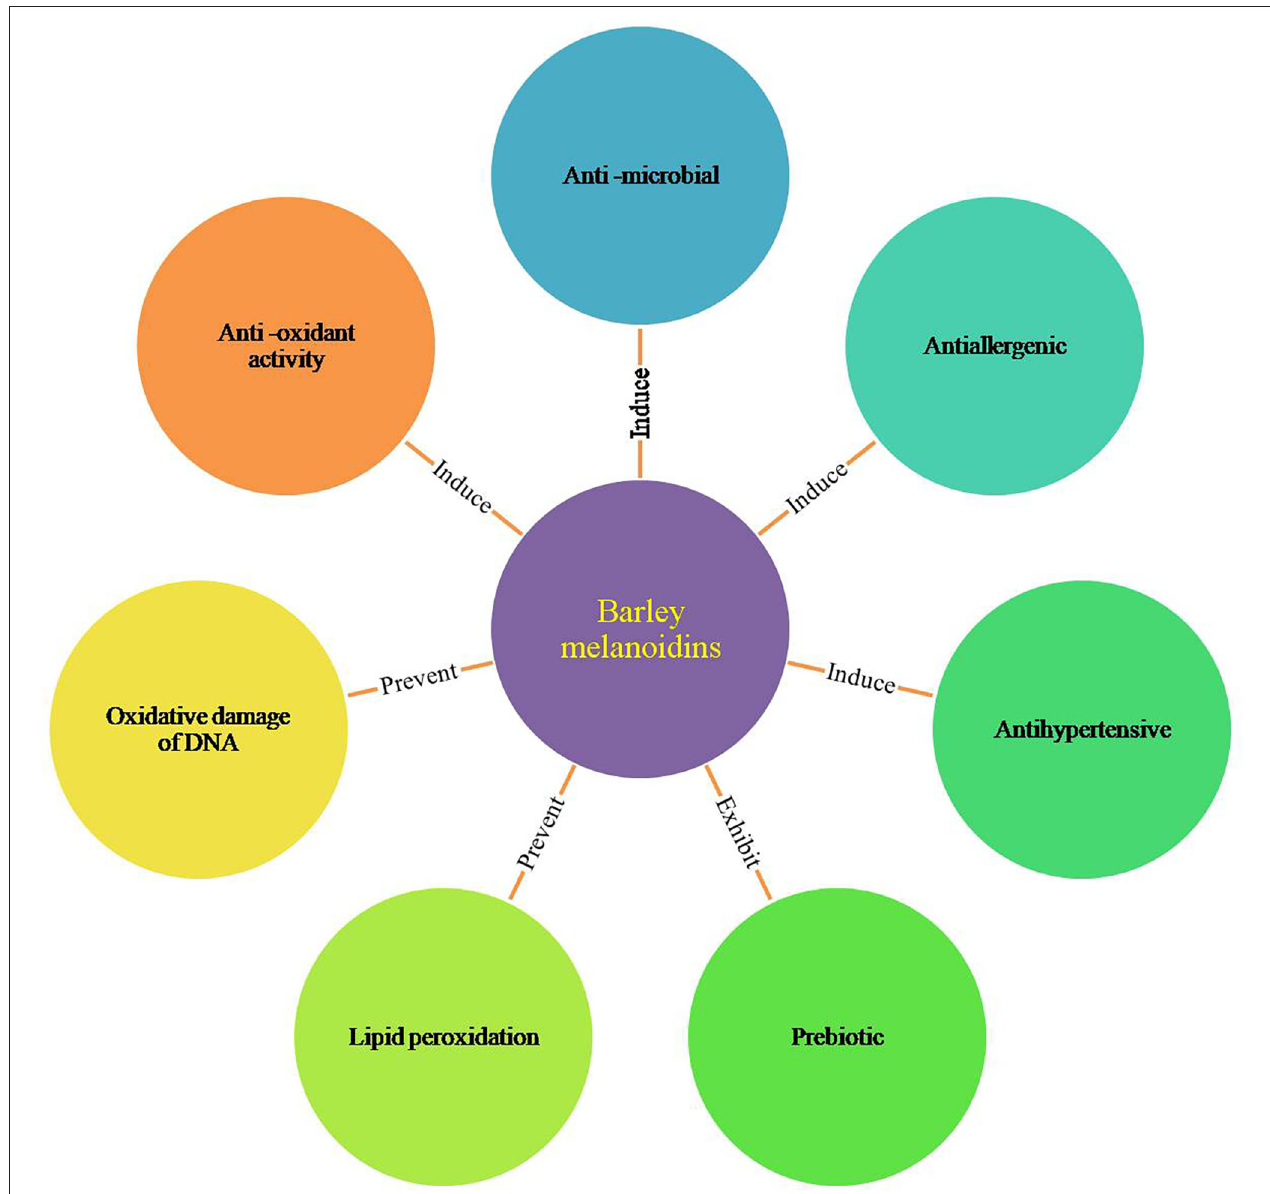
FIGURE 2 | Major biological activities of barley melanoidins.